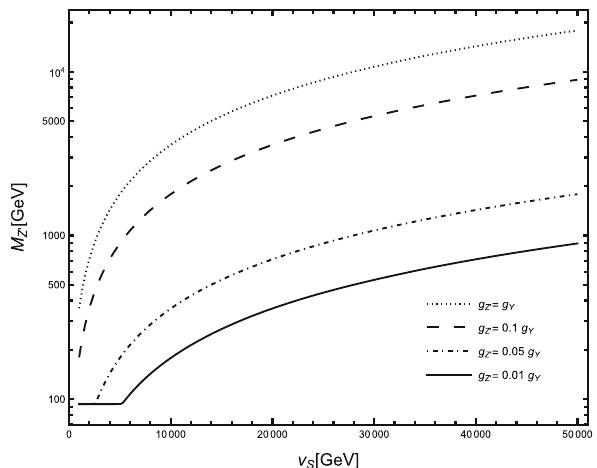
Fig. 2 TeV-range Z (cid:2) mass as a function of v S for different values of the coupling constant g Z